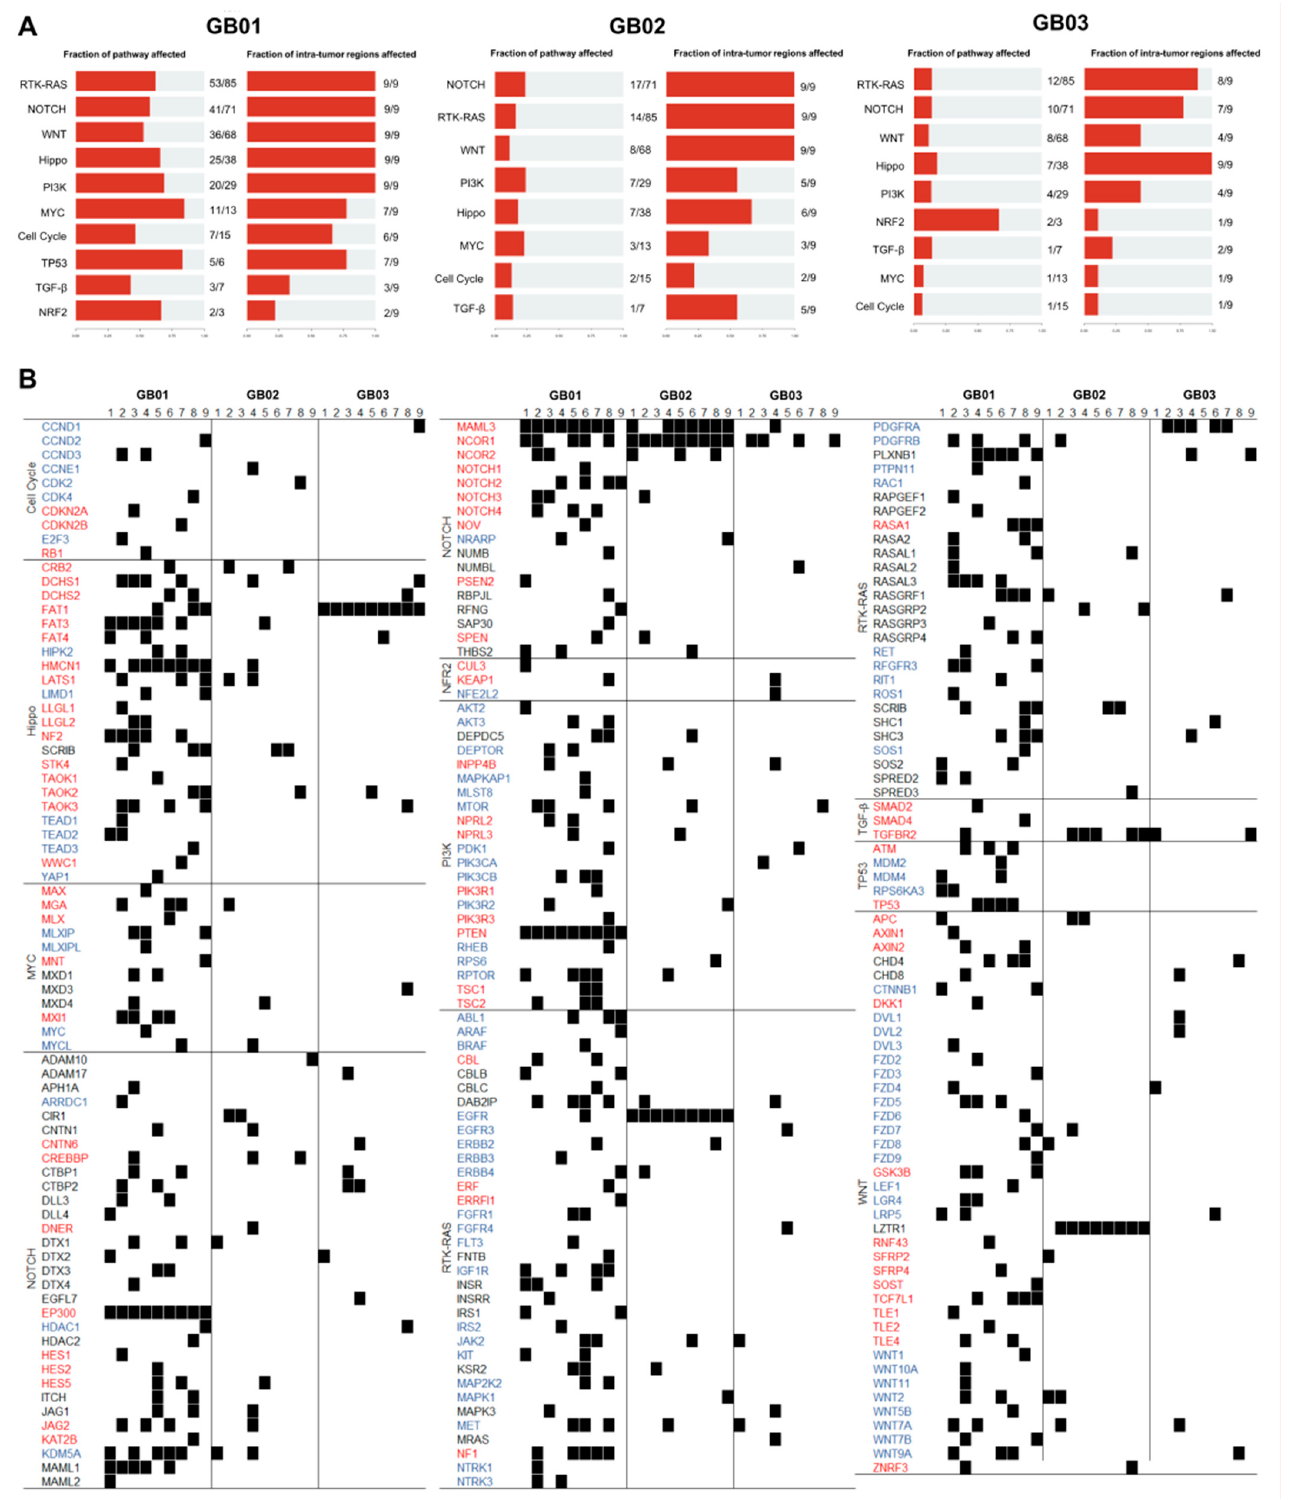
Figure 5. Oncogenic pathways. ( A ) Pathway alteration frequencies. Fraction of mutated genes for each pathway and fraction of tumor regions with mutated genes for that pathway. ( B ) Detail of mutated genes in their respective altered pathways for each of the 27 tumor regions. Black square indicates the presence of a rare mutation. Tumor-suppressor genes are in red and oncogenes are in blue.